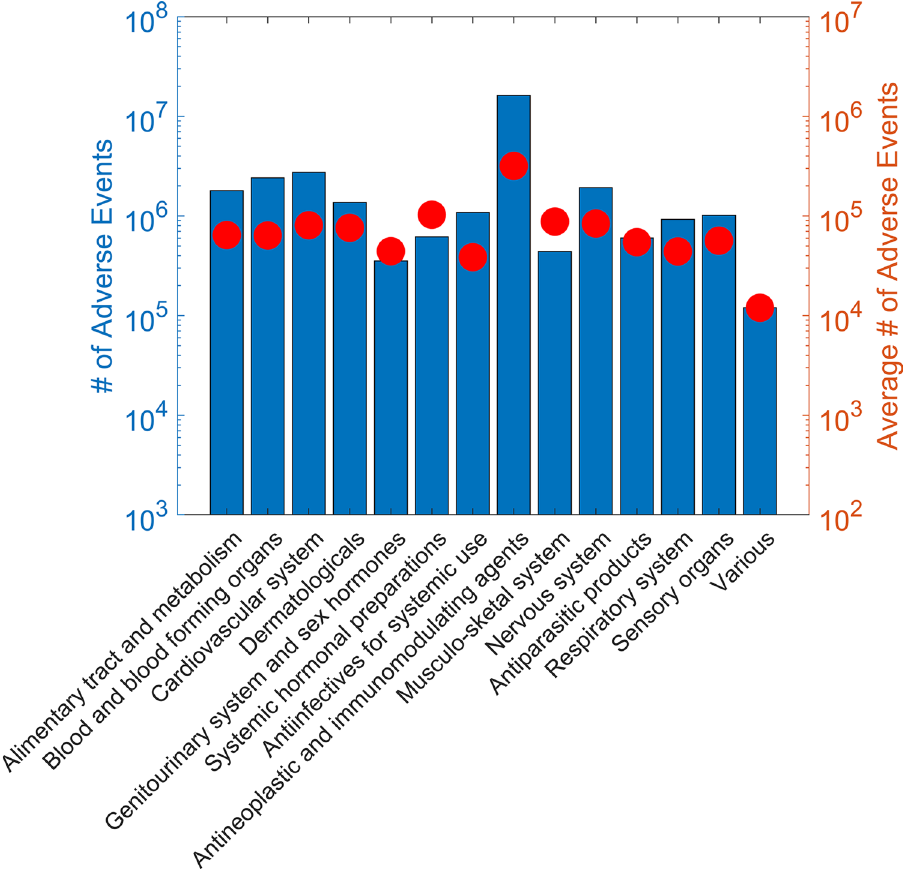
Figure 2. Adverse events in ATC classes. The number of adverse events (left y-axis) were plotted as bars, and the average number of adverse events (right y-axis) were plotted as circles for 14 ATC classes which are depicted on the